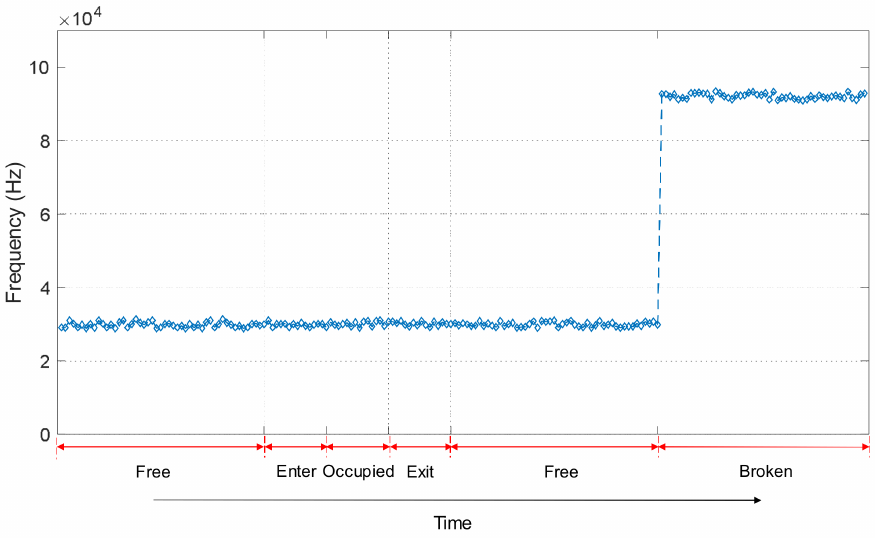
Figure 20. Example of a temporal trend for the feature f Pi in a certain track section S i